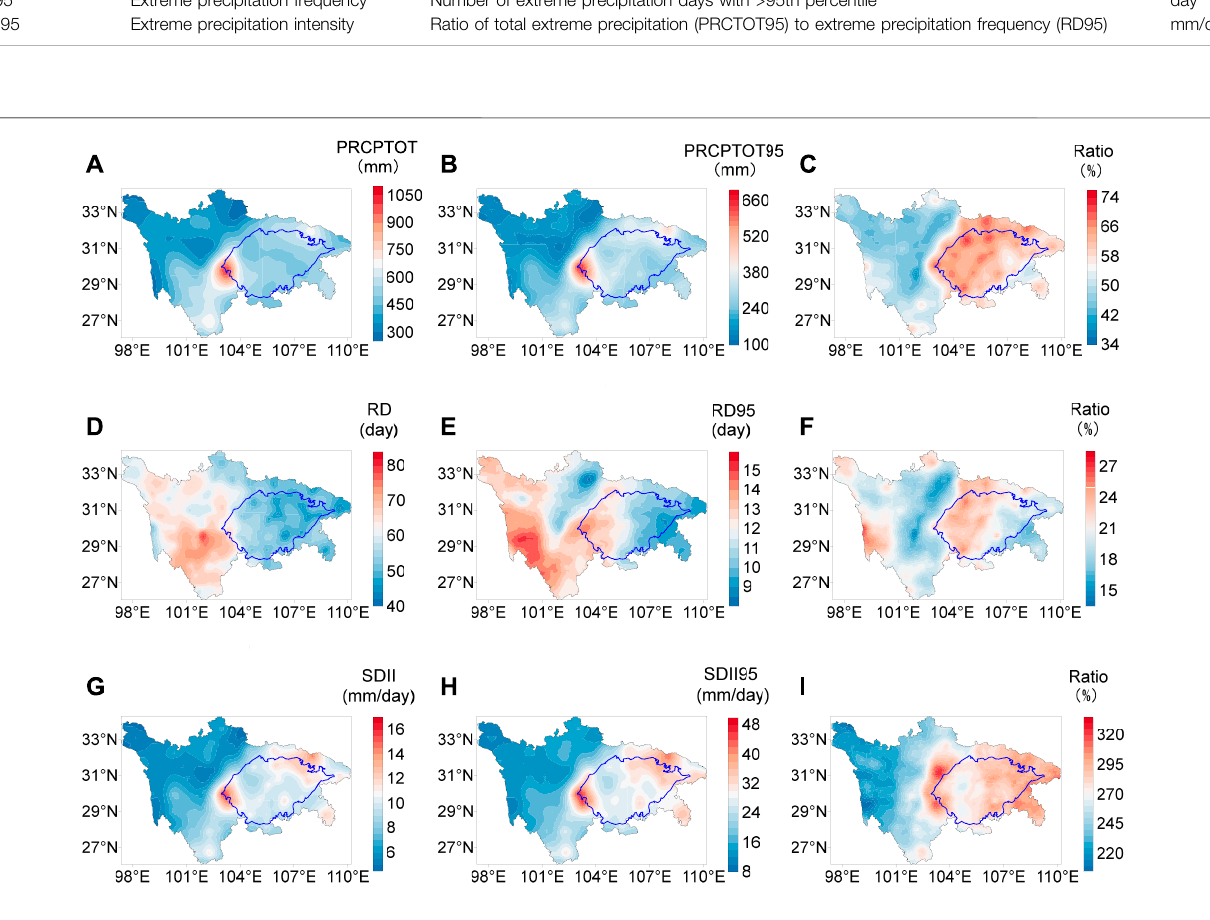
Frontiers in Earth Science |